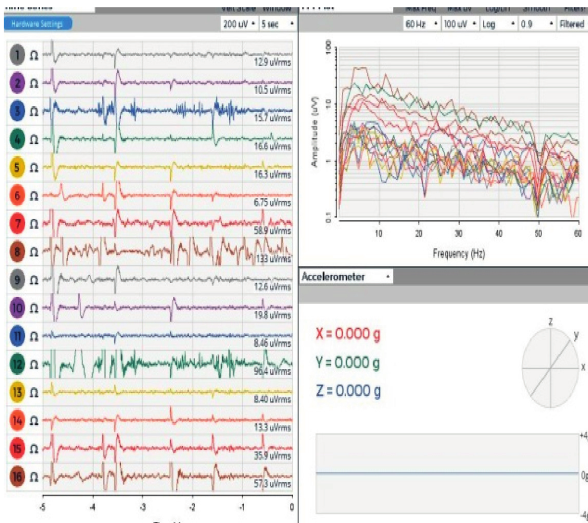
Figure 13: The EEG of pull action idea in the dynamic state.